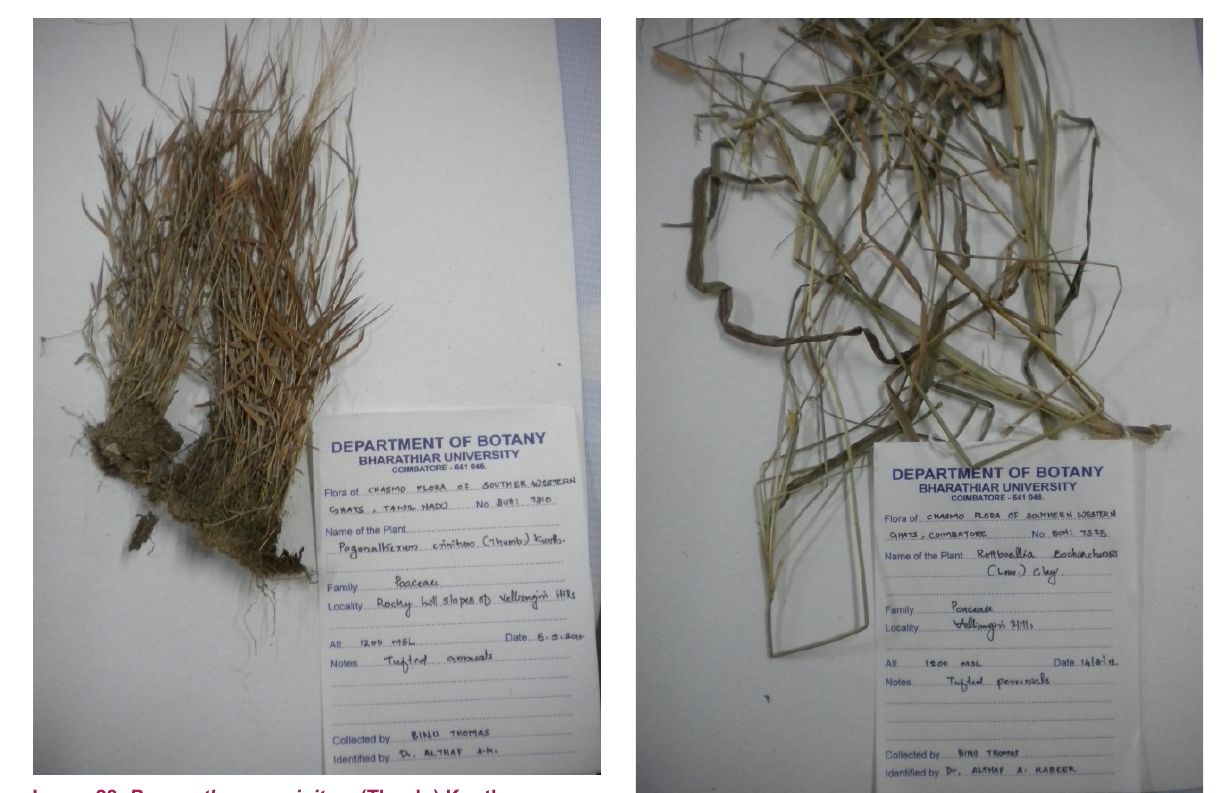
Image 28. Pogonatherum crinitum (Thunb.) Kunth.